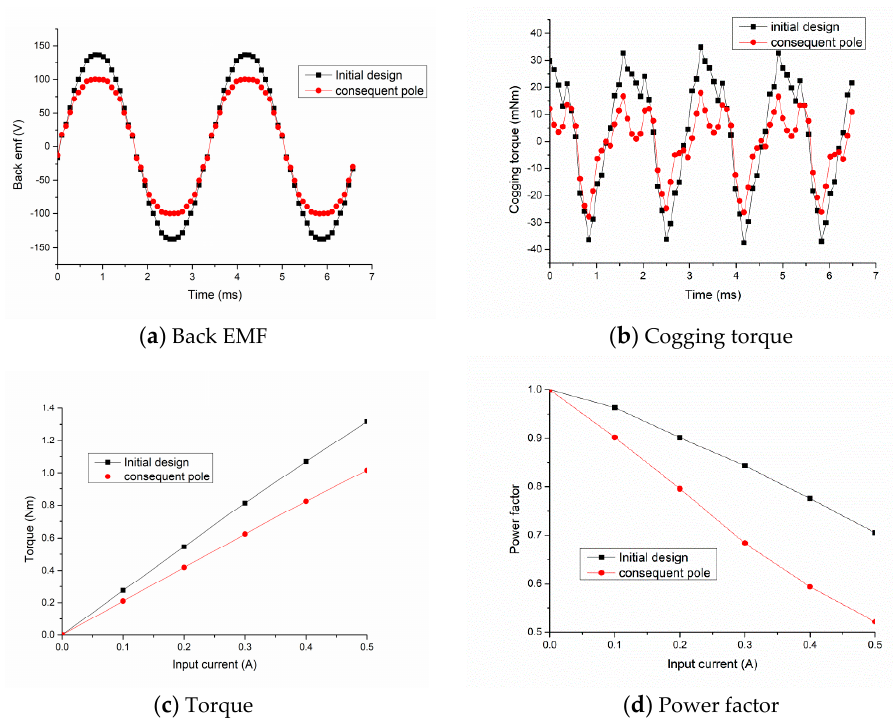
Figure 13. Overall performance comparison of CPM with the initial design and the consequent pole magnet